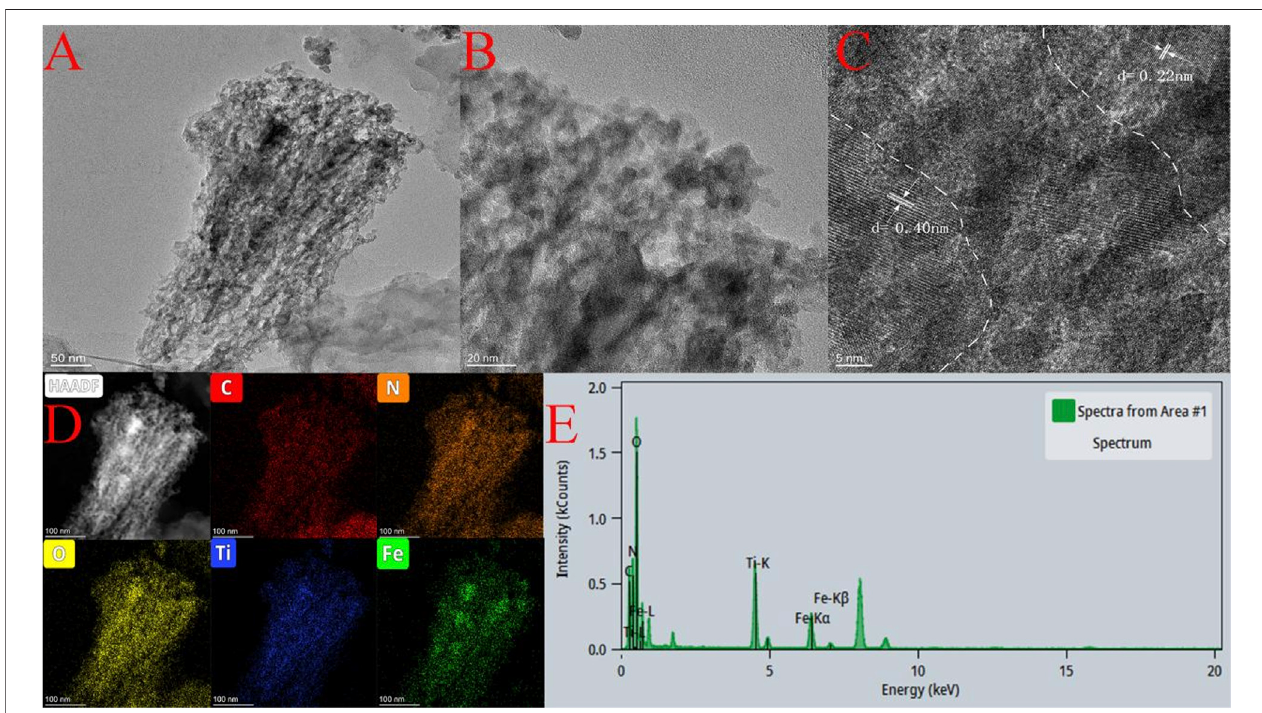
FIGURE 3 | (A,B) TEM images of Fe-C 3 N 4 /Ti 3 C 2 , (C) HR-TEM of Fe-C 3 N 4 /Ti 3 C 2, (D,E) EDS of Fe-C 3 N 4 /Ti 3 C 2